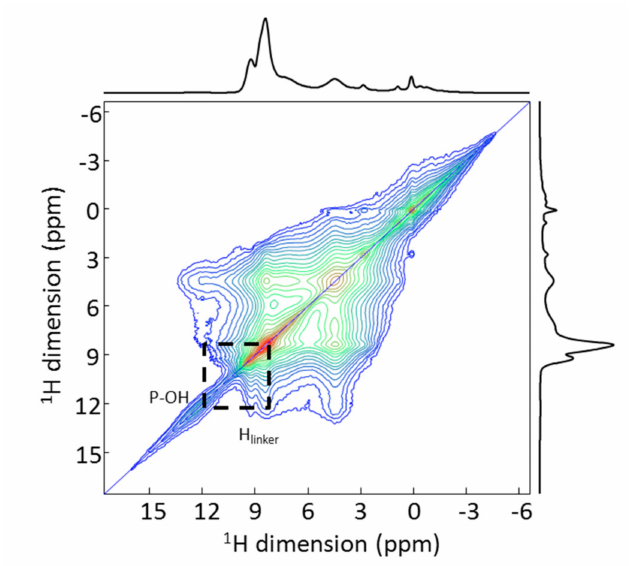
Figure 6. 2D 1 H- 1 H spin diffusion NMR spectrum of CD-P coated ATP-loaded nanoMIL-100(Al). The dash lines indicate the spatial proximity between a phosphate proton and a proton from the linker of the